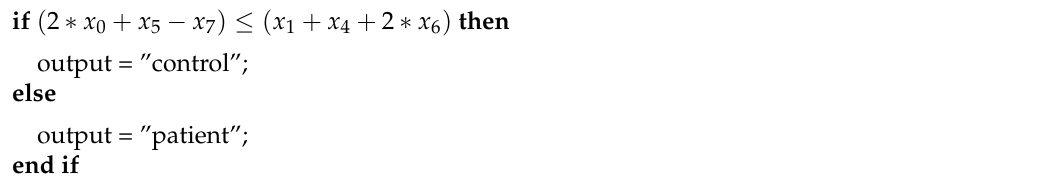
Algorithm 2 The best performing model evolved by CGP among all the 20 runs.